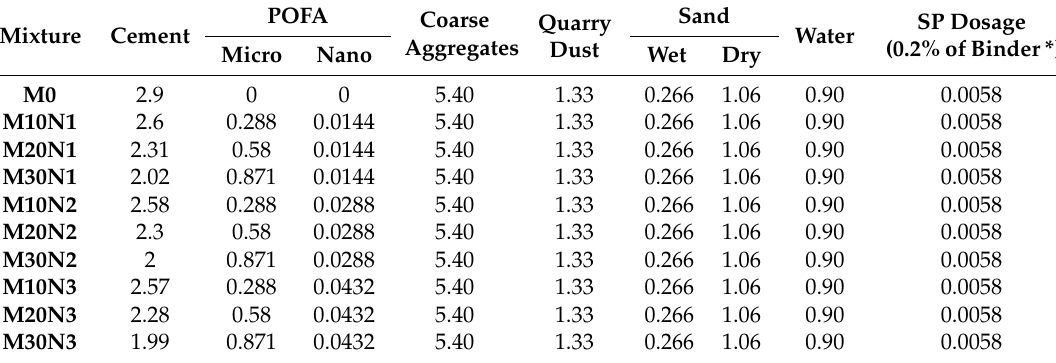
Table 2. Batch weights (kg) of different constituent materials in various concretes (Batch volume = 0.001373 m 3